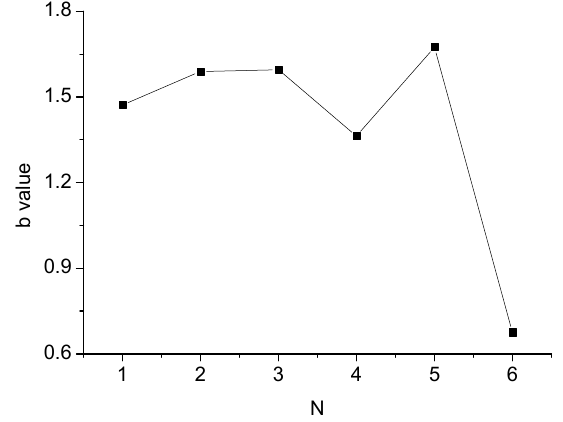
Figure 11. AE b value versus cycle number curves.